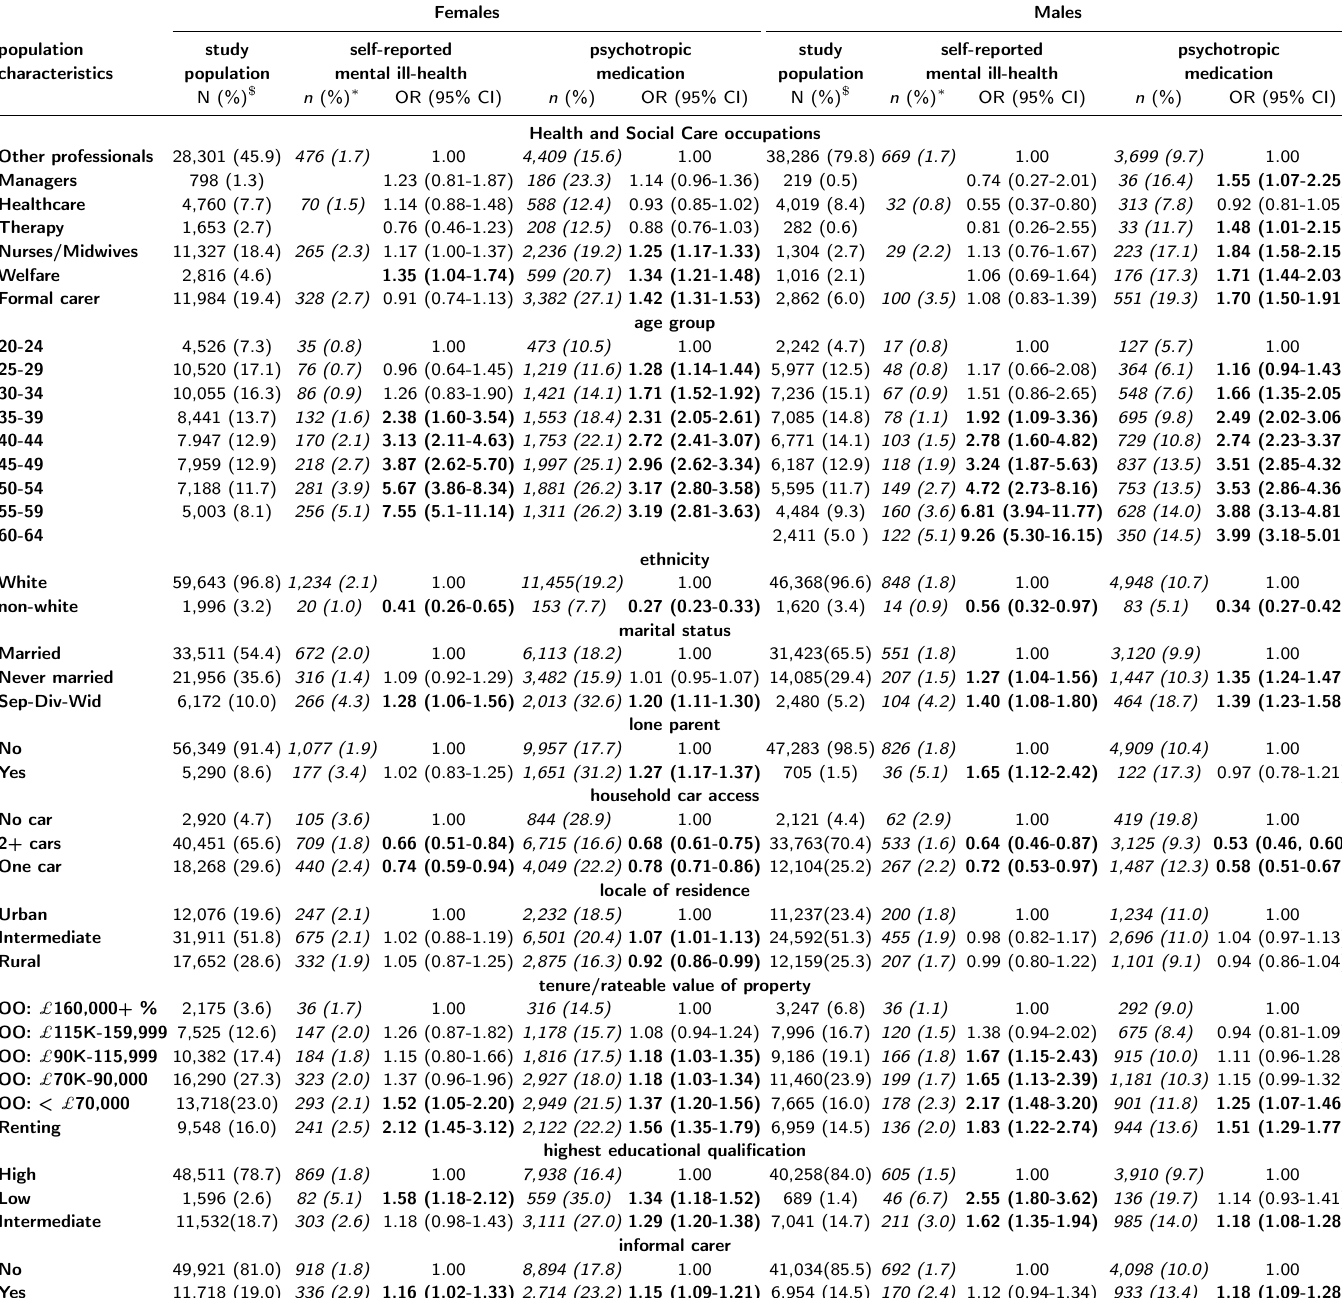
Table 2: Health and social care occupations (females and males separately) Females